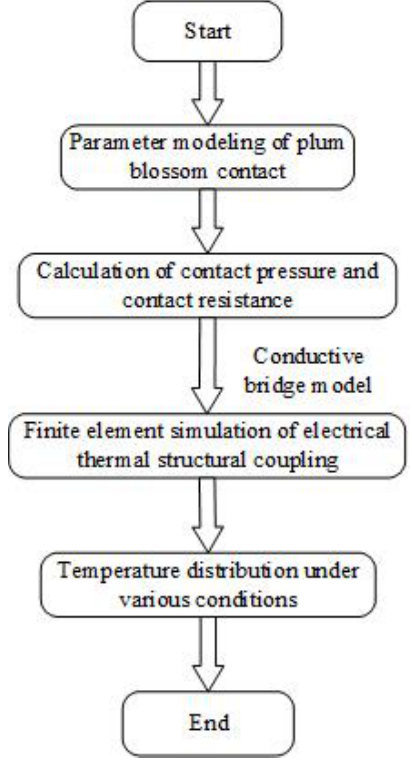
Fig. 4. Simulation flow